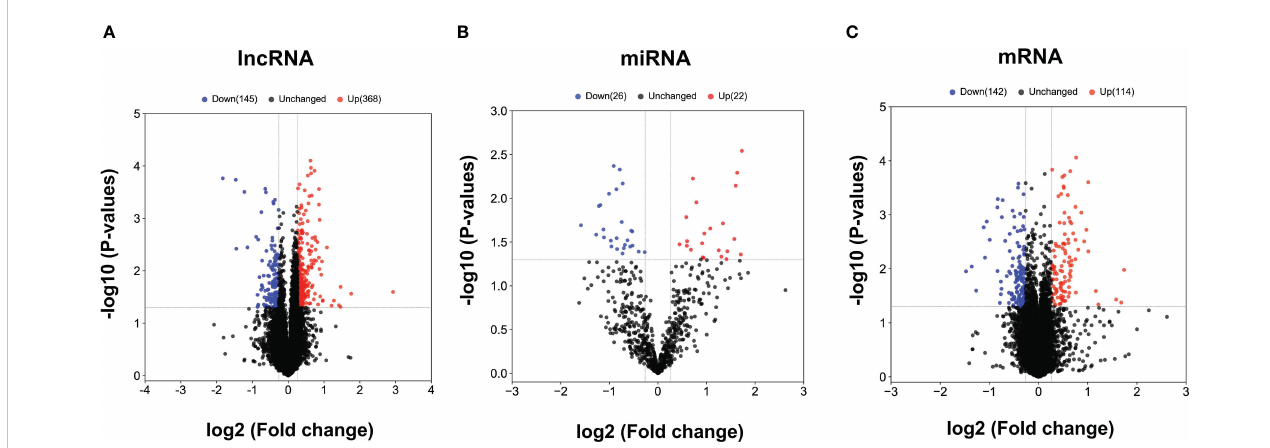
FIGURE 1 The volcano plots of differentially expressed lncRNAs, miRNAs and mRNAs between CHB patients and SC HBV controls. (A) Results of differentially expressed lncRNAs expression analysis between CHB (n = 3) and SC HBV (n = 3) patients. (B) Results of differentially expressed miRNA expression analysis between CHB (n = 3) and SC HBV (n = 3) patients. (C) Differentially expressed miRNA expression analysis between CHB (n = 3) and SC HBV (n = 3) patients. The abscissa is log2 (FC value) and the ordinate is -log10 ( P value). Blue dots are downregulated genes, red dots are upregulated genes, and black dots are genes that were the same between the two